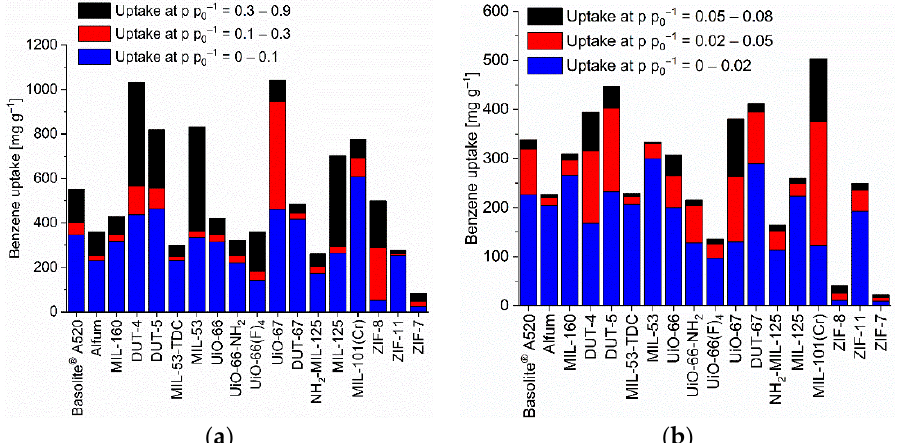
Figure 2. Benzene uptake capacity (at 293 K) of the different MOFs at different relative pressures. ( a ) At relative pressures of 0.1, 0.3 and 0.9; ( b ) at relative pressures of 0.02, 0.05 and 0.08 (specific values in Table S5). For the surface-specific uptake at p p 0 − 1 = 0.1 see Figure